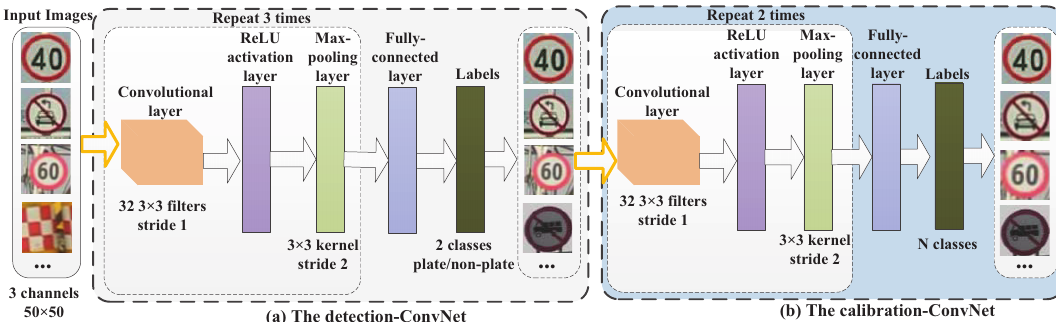
Figure 6. The structure of the cascaded ConvNet-based